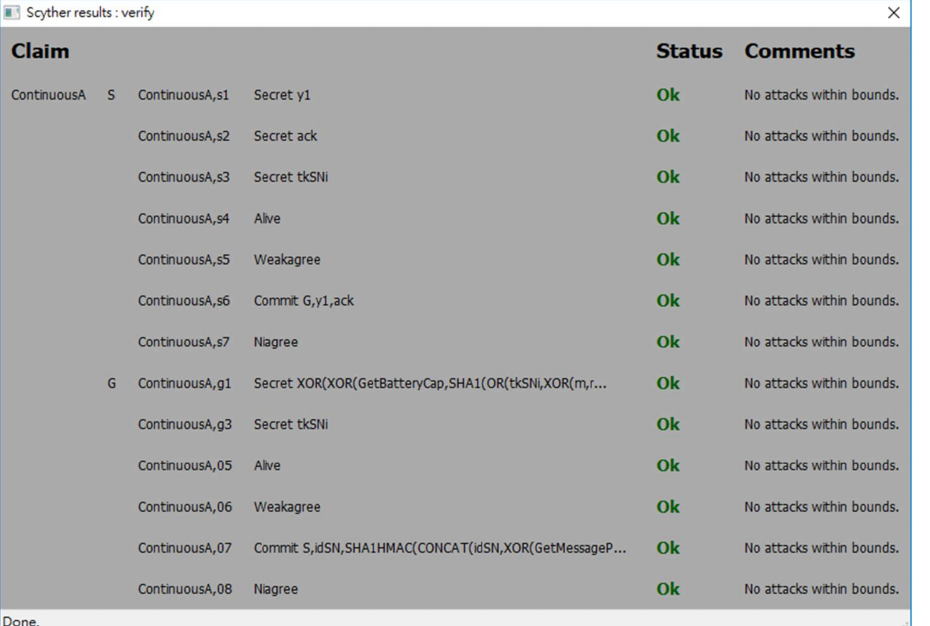
Figure 11. The security analysis result of the continuous authentication phase in Condition (2).